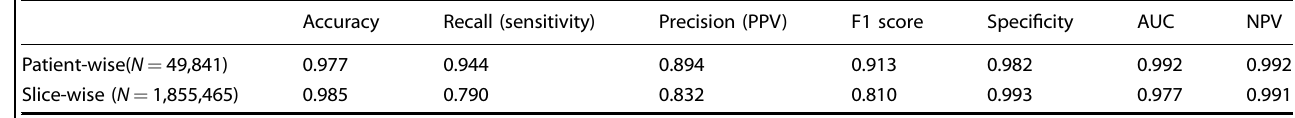
Table 1. Diagnostic performance of AI in the external validation set (full analysis set: 49,841 patients, 1,855,465 slices).